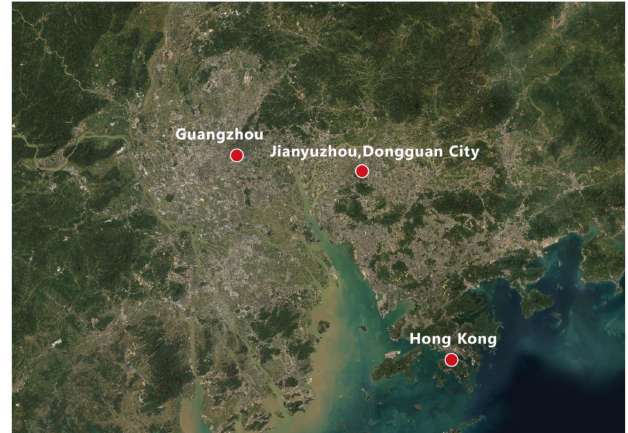
Figure 2. Initial theoretical model.